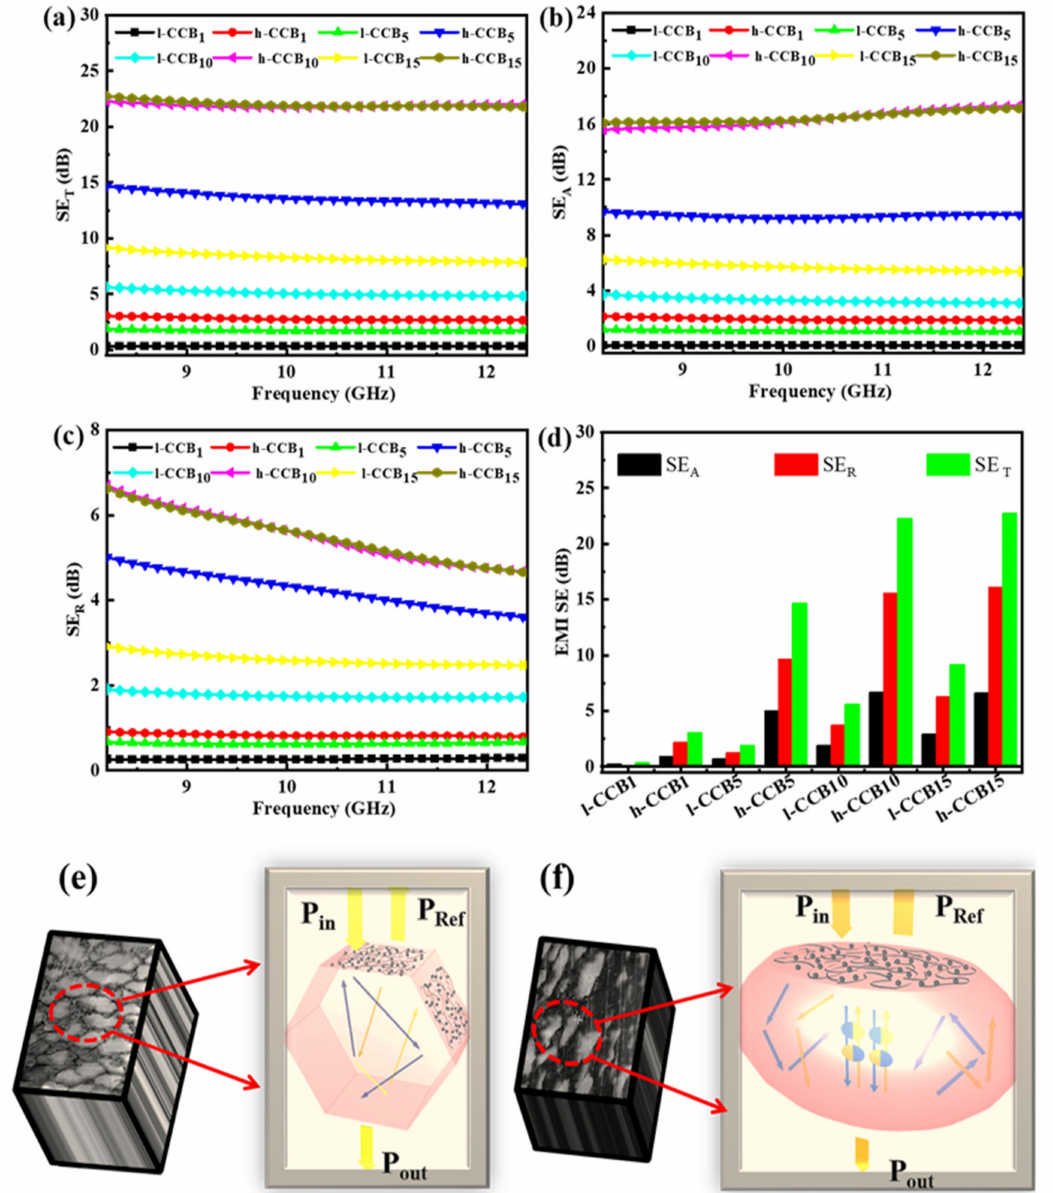
Figure 9. ( a ) SE T ; ( b ) SE A ; and ( c ) SE R of UHMWPE/h-CCB and UHMWPE/l-CCB composites with different CCB contents; as well as ( d ) Comparison of EMI SE of UHMWPE/h-CCB and UHMWPE/l-CCB composites with different CCB weight ratios at the thickness of approximately 1.5 mm; ( e ) EMI shielding mechanism diagram of UHMWPE/l-CCB; and ( f ) UHMWPE/h-CCB